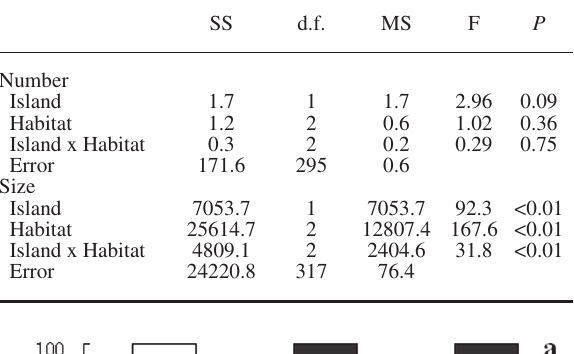
Table 3. – results of two-way crossed AnoVA of total abundance and size of white trevally in relation to island and reef habitat type.